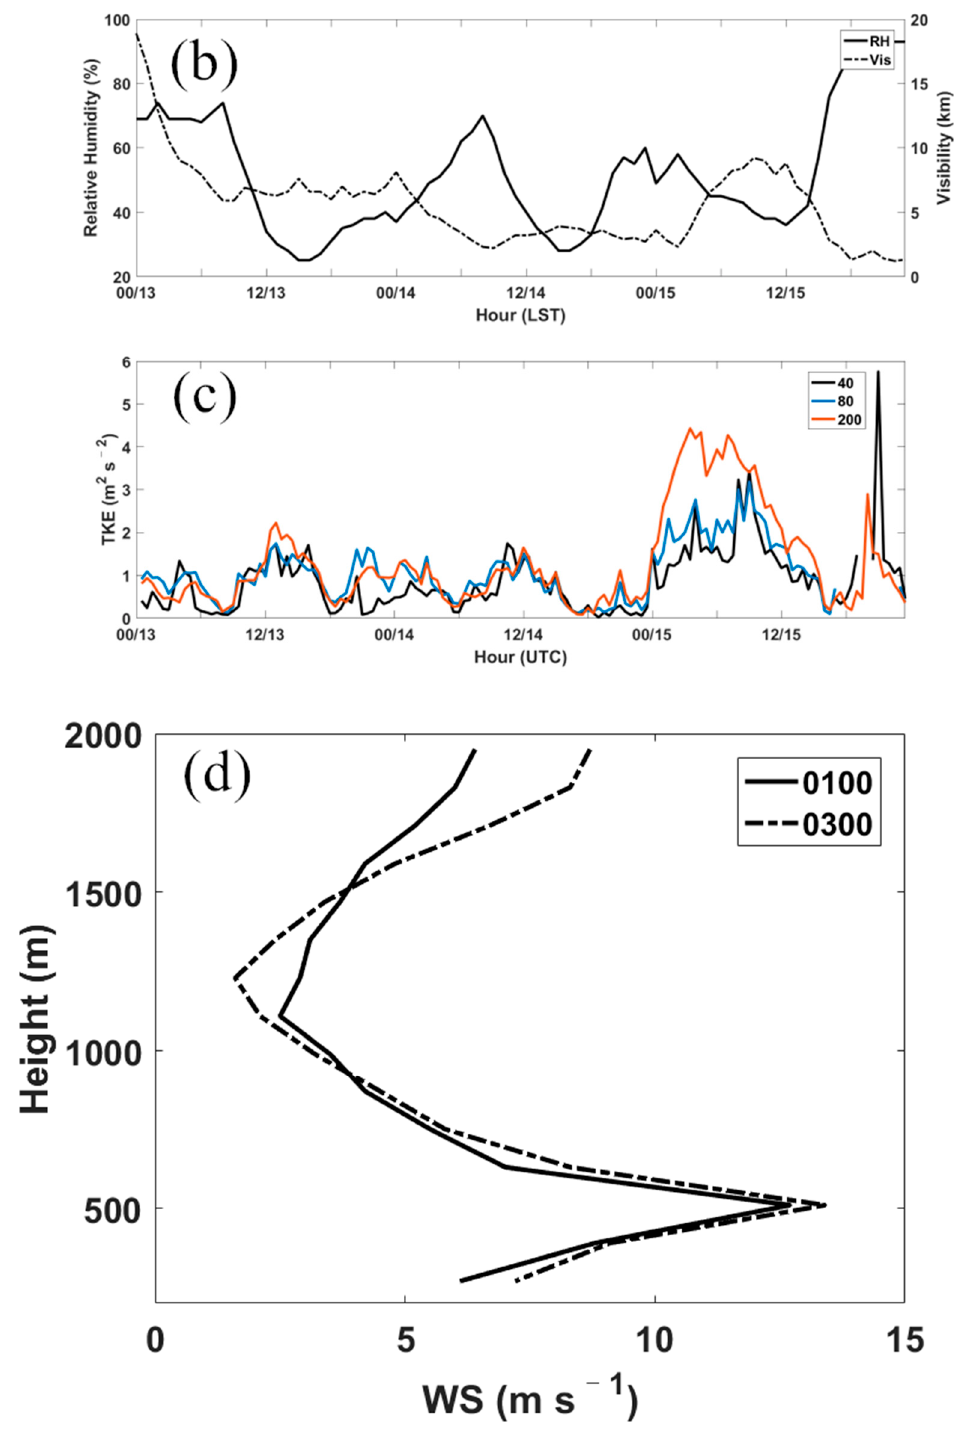
Figure 7. Temporal variations of ( a ) PM 2.5 mass concentration, ( b ) relative humidity, visibility, and ( c ) TKE from 0000 LST 13 February to 2300 LST 15 February 2015. ( d ) Wind profiles at 0100 and 0300 LST